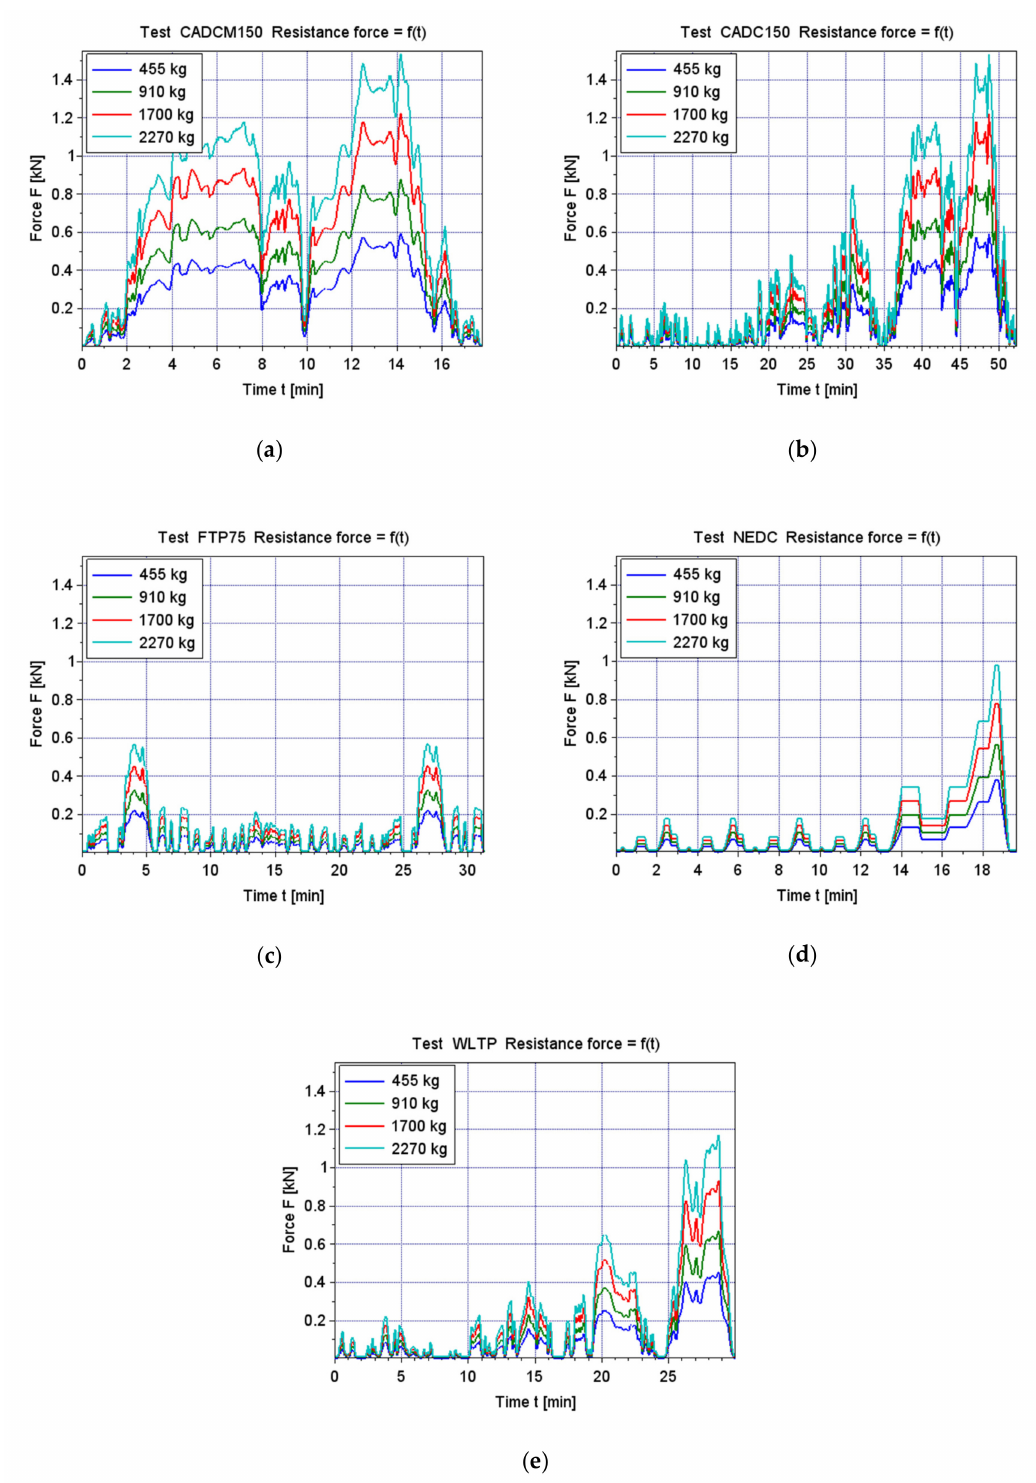
Figure 3. Simulation results for the test in the form of resistance force waveforms for selected vehicle masses: Light green line—Vehicle weight 2270 kg; red line—Vehicle weight 1700 kg; green line—Vehicle weight 910 kg; blue line—Vehicle weight 455 kg: ( a ) CADCM150; ( b ) CADC150; ( c ) FTP75; ( d ) NEDC; ( e )